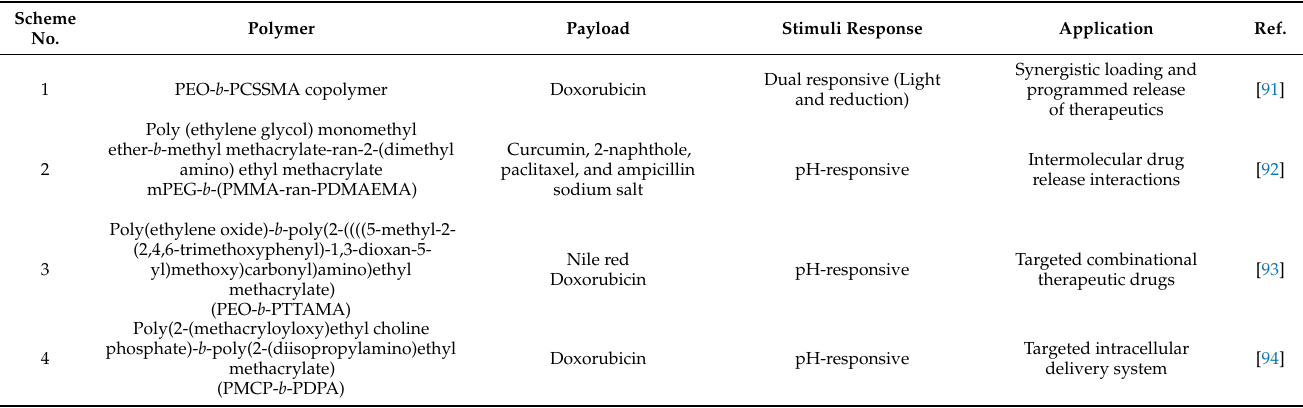
Table 2. Recent research evidence based on the development of stimuli-responsive polymersomes. Scheme